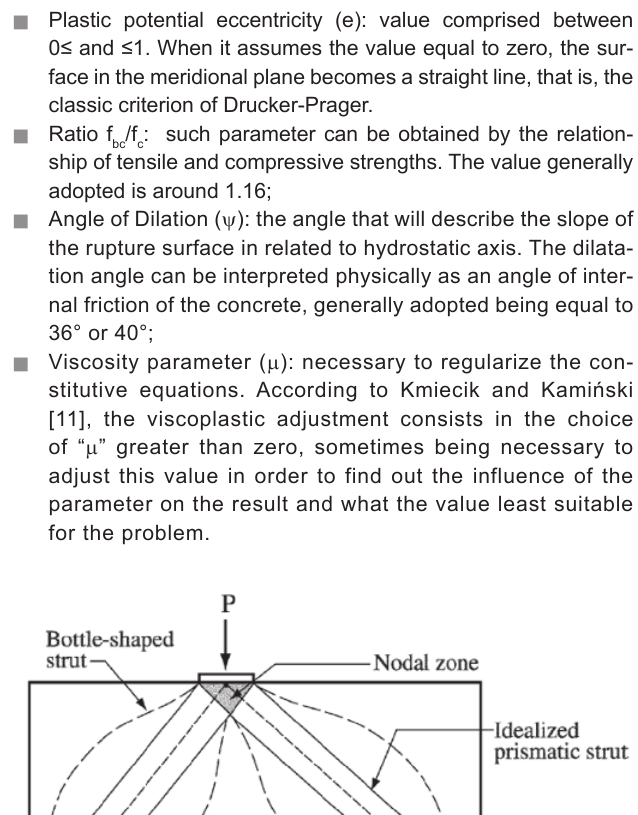
Strut-and-tie models according to Silva and Giongo (adapted from [24])